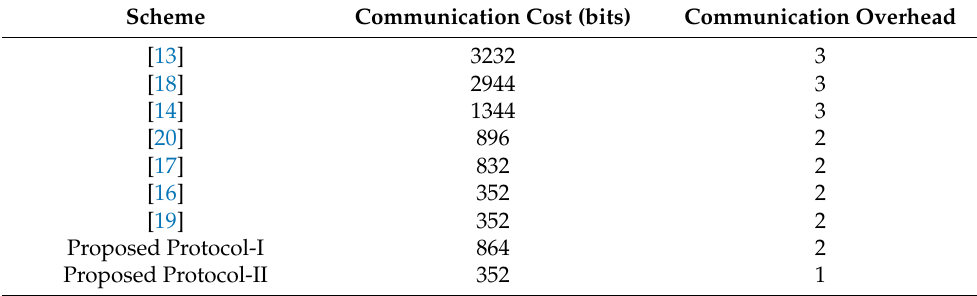
Table 4. Communication cost